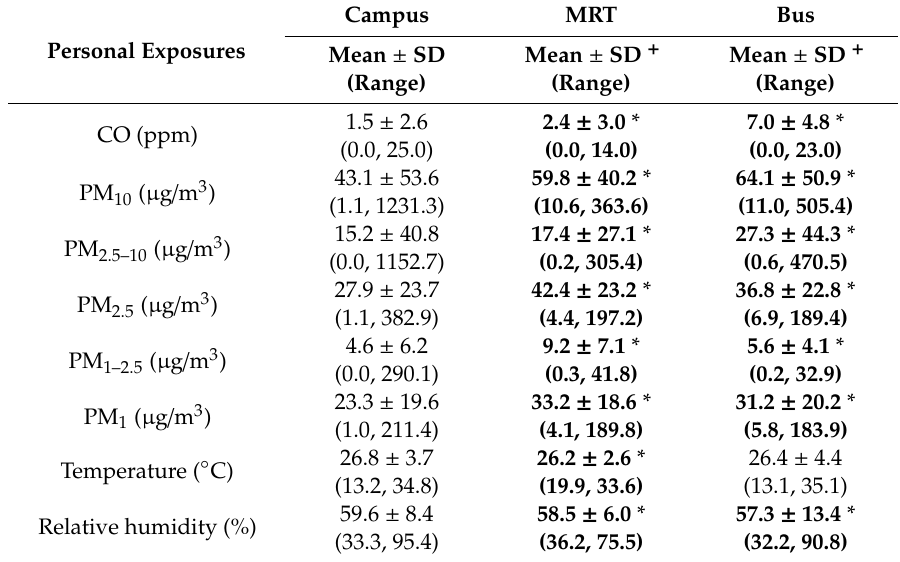
Table A2. Personal exposures to air pollution and meteorological conditions in di ff erent